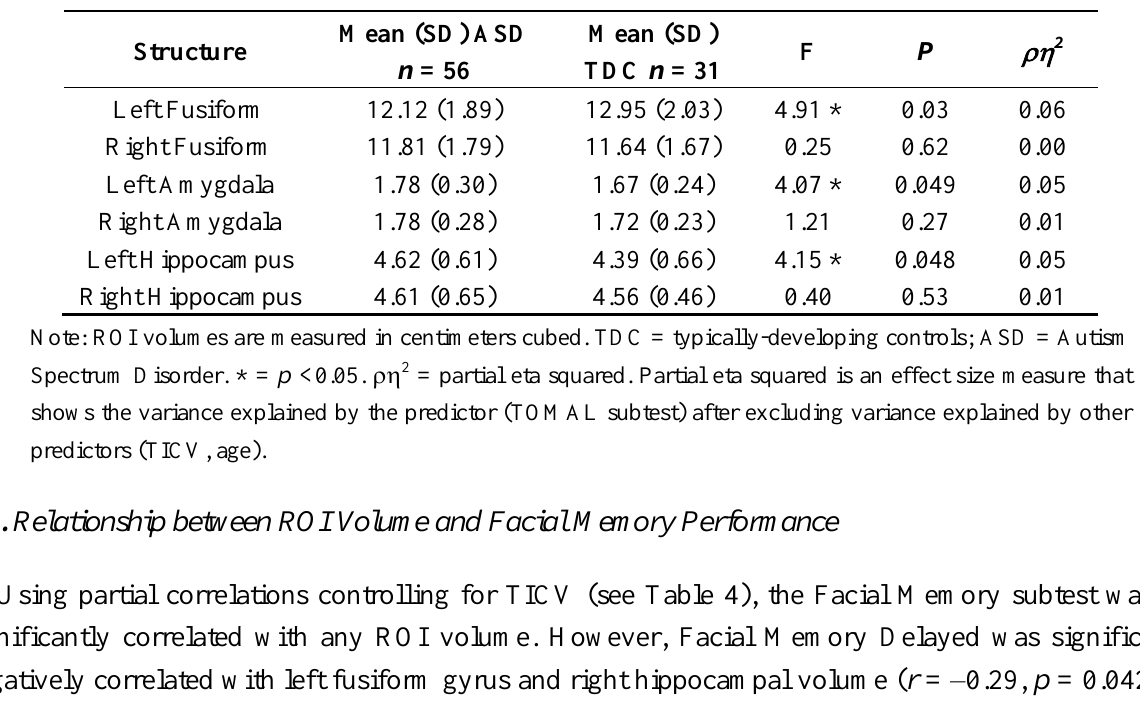
Table 3. ROI volume multivariate analysis controlling for TICV and